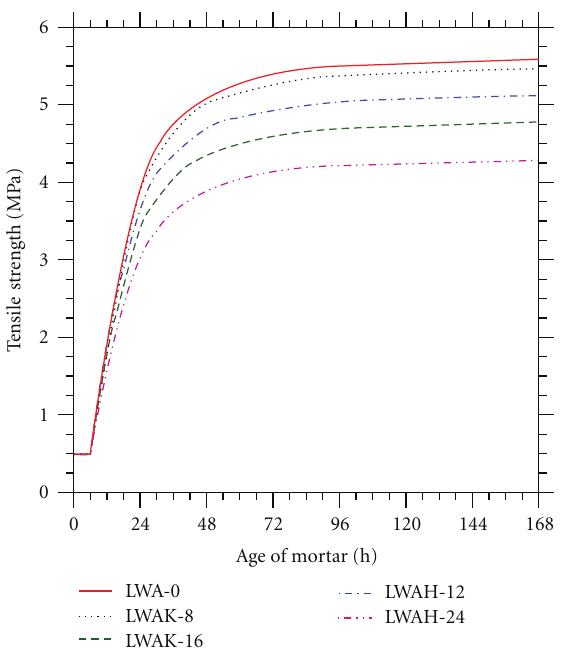
Figure 4: Fitted autogenous shrinkage development of plain mortar and mortars with the prewetted LWAs